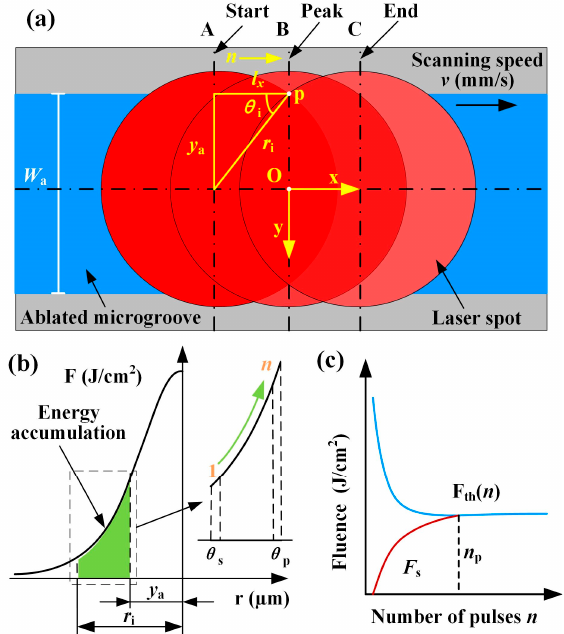
Figure 3. Schematic diagram of laser spot trajectory and energy accumulation. ( a ) The trajectory of the pulsed laser spot. ( b ) Schematic of energy accumulation of multiple pulses. ( c ) E ff ect of the number of pulses on the fl uence accumulation and ablation threshold.